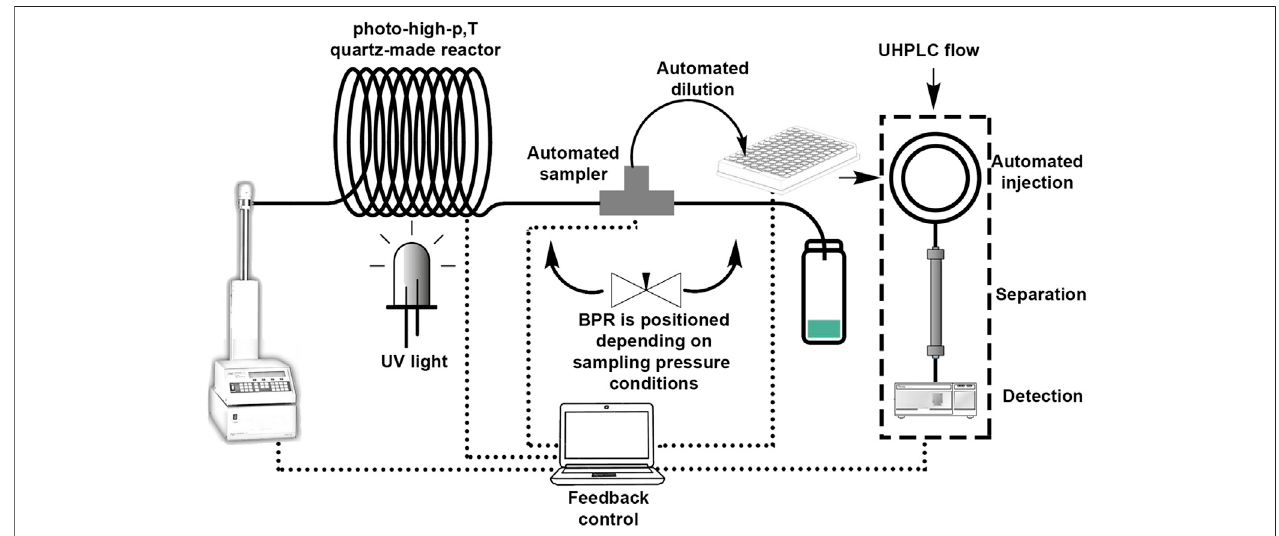
SCHEME 1 | Experimental setup and process